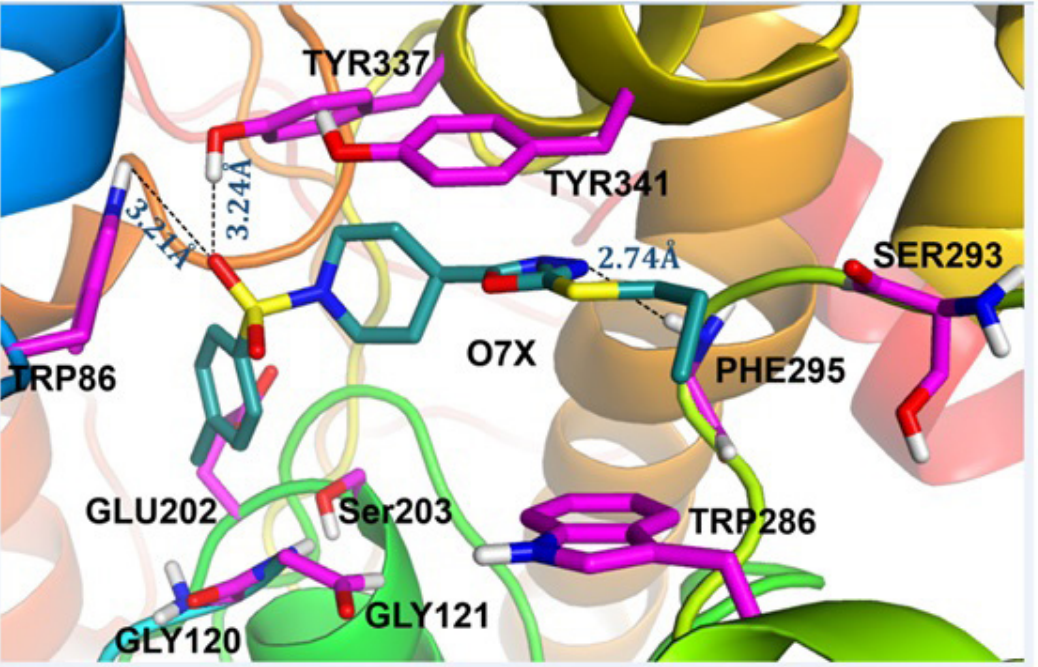
FIGURE 3 - Docked conformation of AChE inhibitors 7x (Cyan), 7x (Magenta) superimposed over experimental conformation of donepezil (Magenta) in AChE main binding